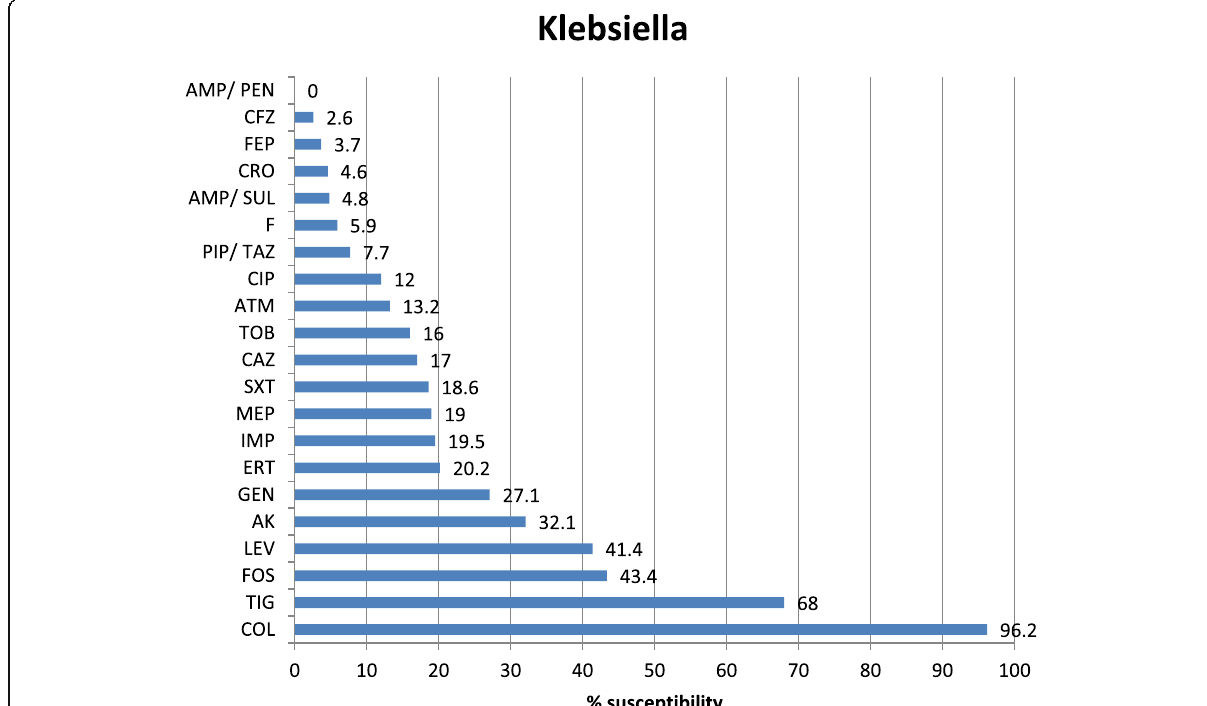
Fig. 2 Antibiotic susceptibility of the Klebsiella pneumoniae . Klebsiella Klebsiella pneumoniae , AMP/PEN ampicillin/penicillin, CFZ cefazolin, FEP cefepime, CRO ceftriaxone, AMP/SUL ampicillin/sulbactam, F nitrofurantoin, PIP/TAZ pipracillin/tazobactam, CIP ciprofloxacin, ATM aztreonam, TOB tobramycin, CAZ ceftazidime, SXT sulfa-trimethoprim, MEP meropenem, IMP imipenem, ERT ertapenem, GEN gentamycin, AK amikacin, LEV levofloxacin, FOS fosfomycin, TIG tigecylcine, COL blood bacteremia (7.48%, n = 3386 vs 4.16%, n = 1882; 0.44%, n = 202 vs 0.08%, n = 40; and 1.91%, n = 865 vs